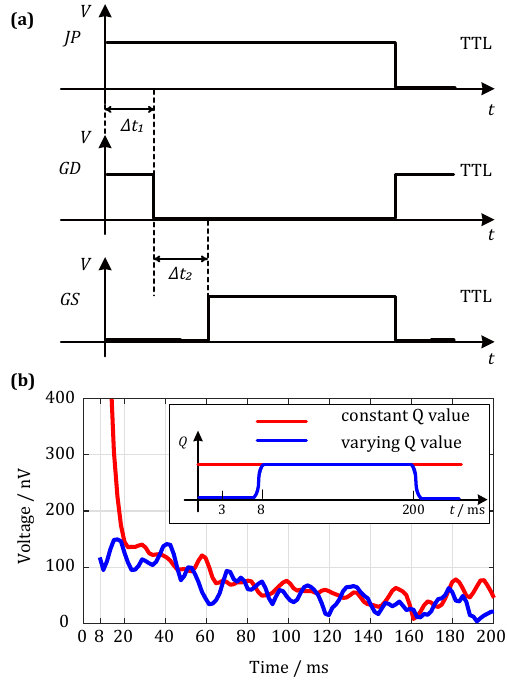
Figure 6. Working flowchart of the Q-switch circuit and the effect to the received signal. ( a ) The operation of the diverter switch G − DS ; ( b ) the received signal with a constant Q (red lines) and a varying Q (blue